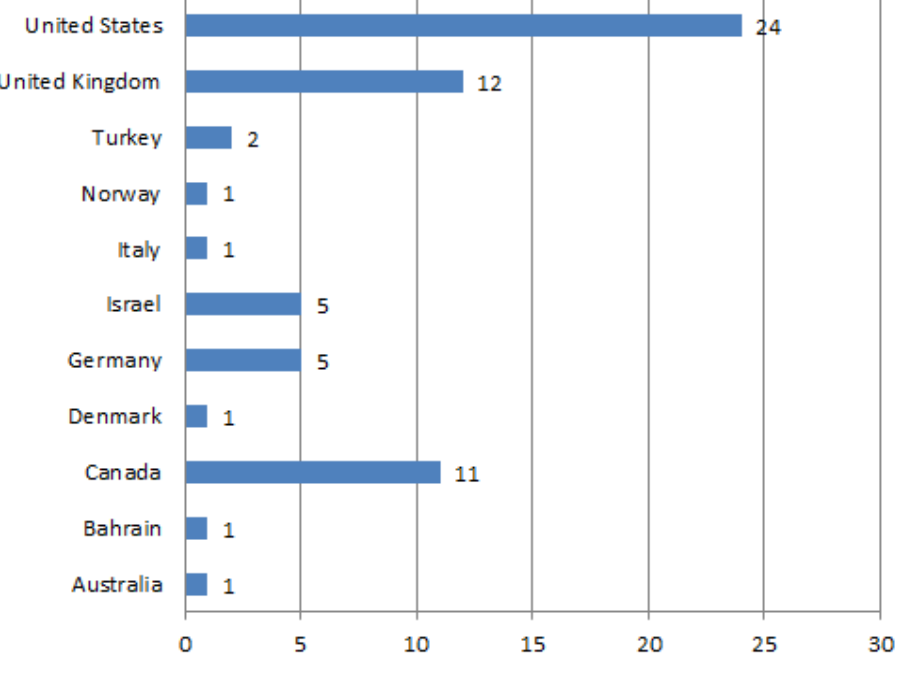
Figure 3 . Frequencies of authors’ country in 33 highly cited articles.